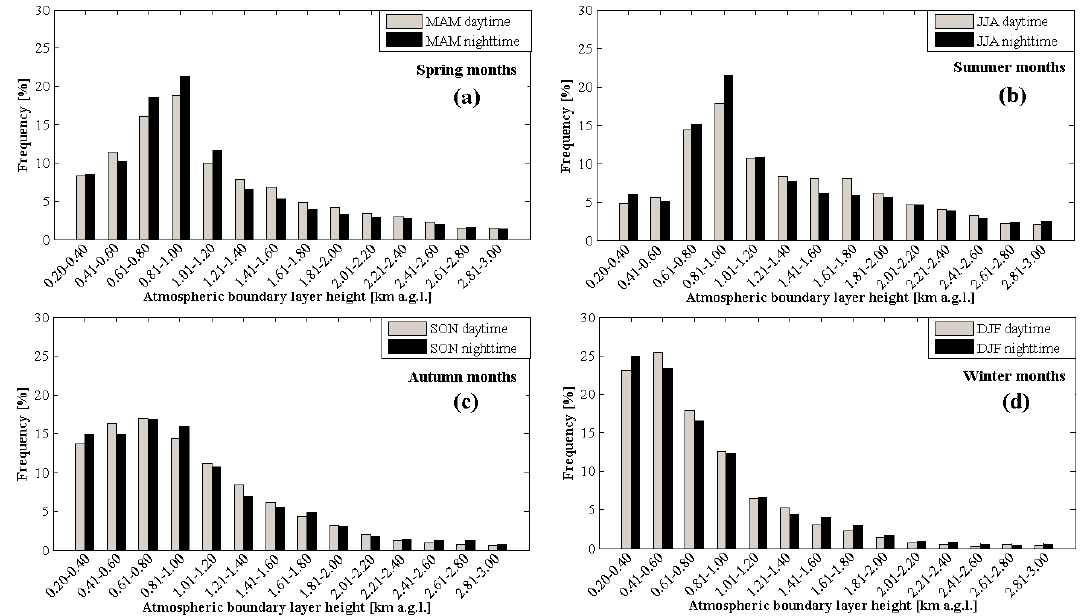
Figure 13. Frequency distribution of ABLHs calculated from the PollyXT lidar and the CHM15k ceilometer observations in Warsaw, for the period from 2008 to 2018, as separated into spring ( a ), summer ( b ), autumn ( c ), and winter ( d ) seasons, as well as daytime (in grey) and nighttime (in black). The ABLH values are separated into classes of 200 m. Merging and homogenization were applied to lidar data from November 2013 to December 2018.